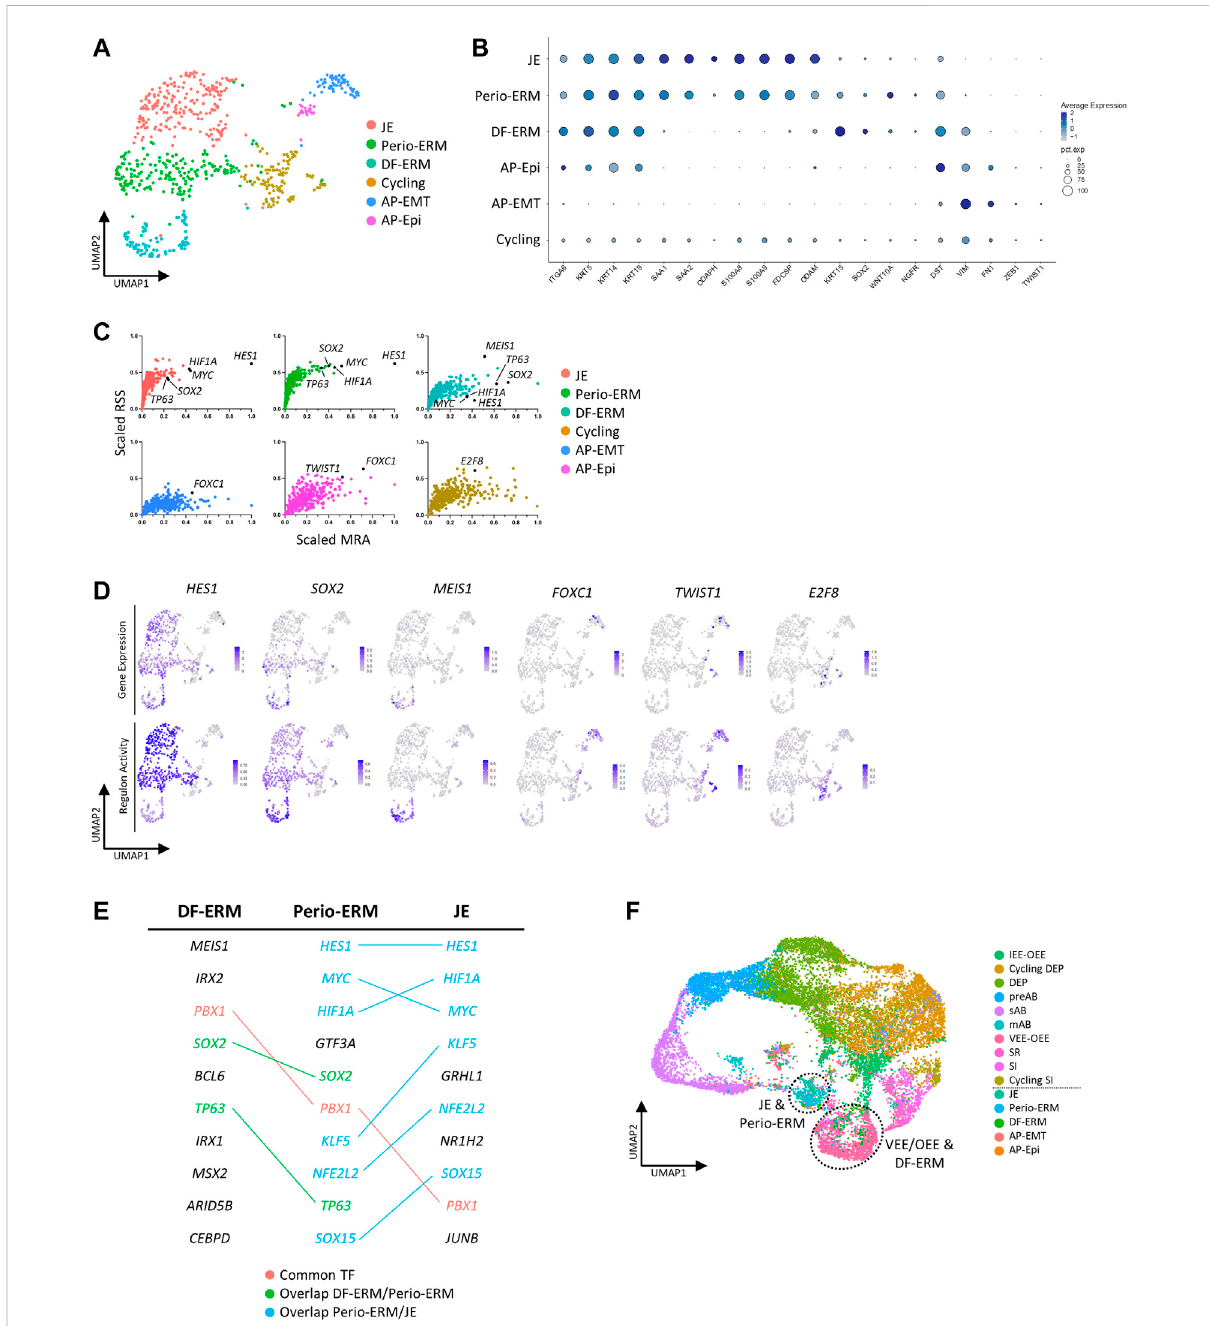
FIGURE 4 Subclustering of human tooth epithelial cells. (A) Annotated UMAP plot of subclustered ‘ Epithelial ’ and ‘ Cycling ’ clusters. (B) Dotplot displaying the percentage of cells (dot size) expressing key marker genes of the different epithelial subclusters (average expression levels indicated by color intensity). (C) Scatter plots (per annotated epithelial cell cluster, color-coded) of scaled RSS and MRA with each dot corresponding to an individual regulon. Black dots indicate the marked regulons. (D) Feature plots of gene expression (top row) and regulon activity (bottom row) of indicated TF/regulons in the epithelial subclusters. Average expression and activity levels are indicated by color intensity (see scale). (E) Table showing the top 10 regulon TFs for DF-ERM, perio-ERM and JE as identi fi ed through combined RSS and MRA (RSS*MRA) analysis. The overlapping regulatory landscape is mapped and color-coded to annotate common TFs (red), TFs present in both DF-ERM and perio-ERM (green) and TFs common to perio-ERM and JE (blue). (F) UMAP plot of integrated mouse and human DE. Dotted lines indicate co-clustering of human DF-ERM and mouse VEE- OEE, and of perio-ERM and